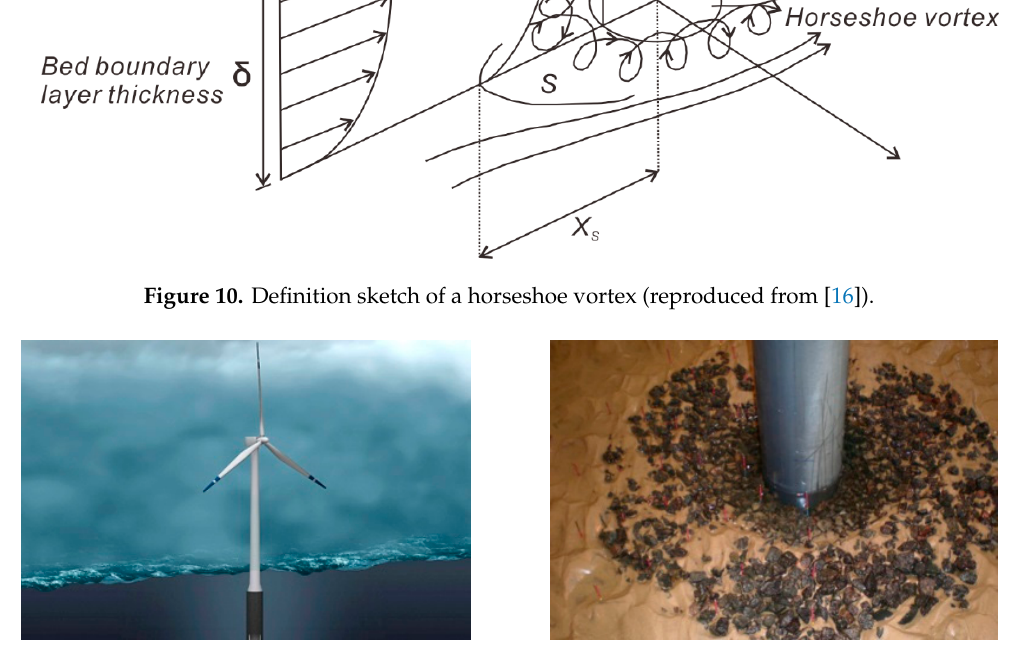
Figure 11. Scouring protection on this 0.2 m diameter Horns Rev1 mono-pile foundation sank 0.077 m after a one hour test at DTU (Technical University of Denmark) [from www.rechargenews.com].